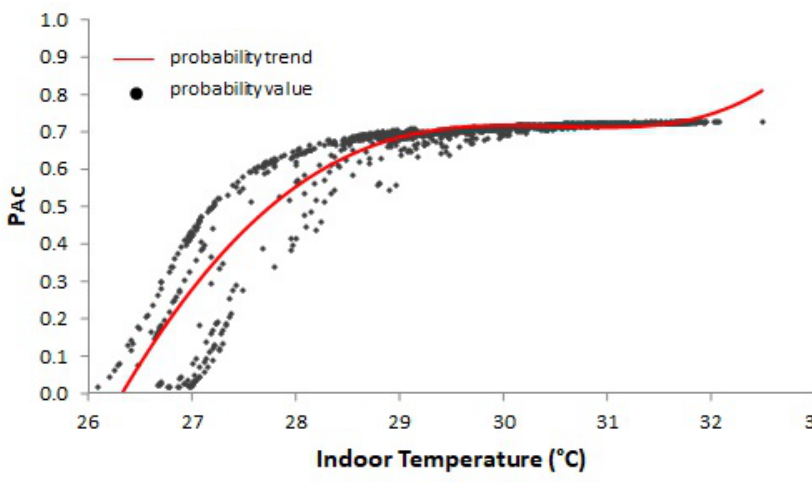
Figure 9. Distribution probability of AC activation by the